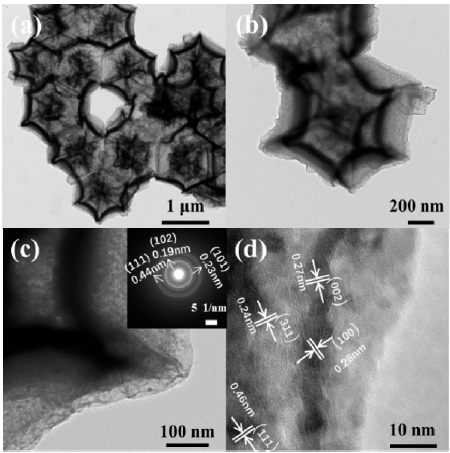
Figure 2. TEM images of ZnO/Co 3 O 4 ( a , b ) and HRTEM ( d ); selected area electron diffraction (illustration in ( c ).